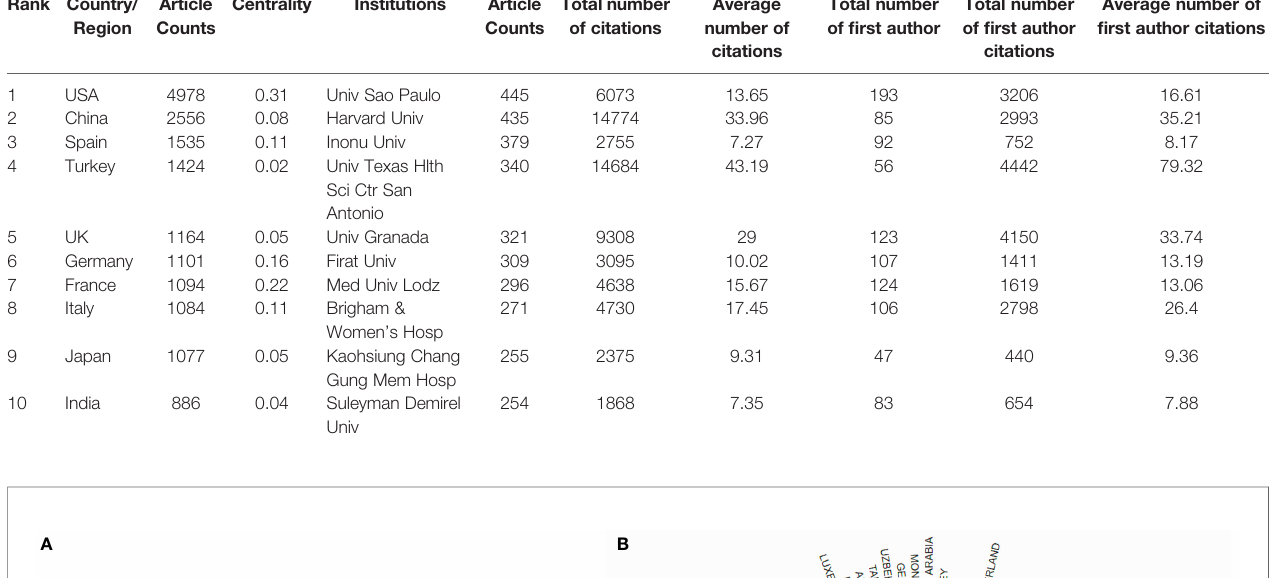
TABLE 1 | The top 10 countries/regions and institutions contributing to publications in melatonin research.